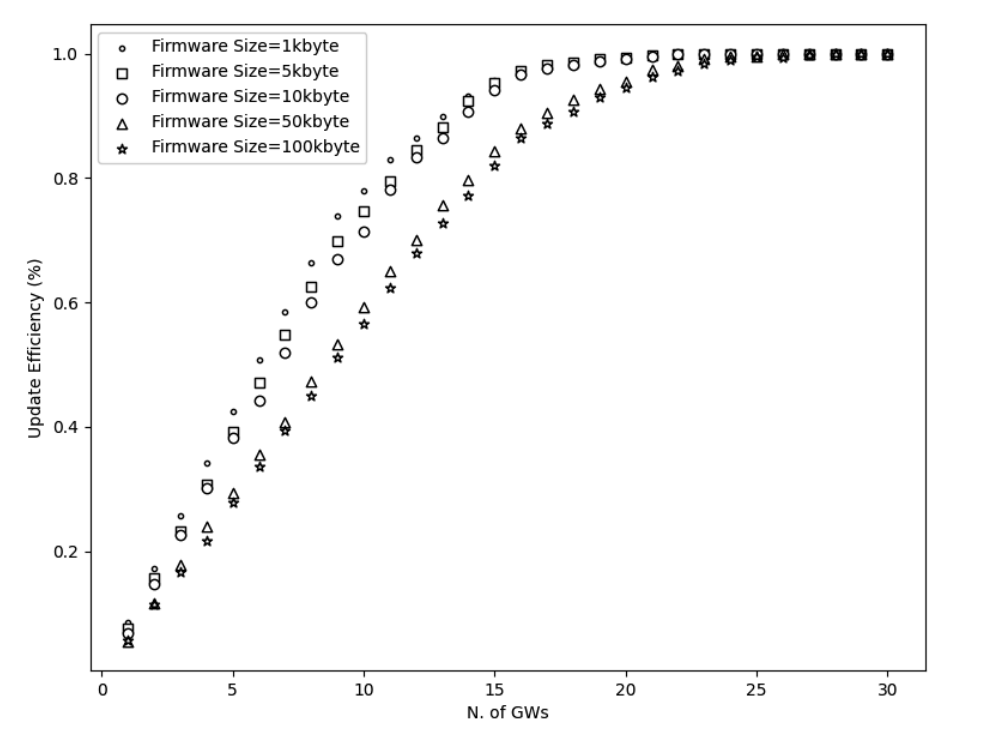
Figure 7. Update efficiency using 10,000 nodes and different firmware